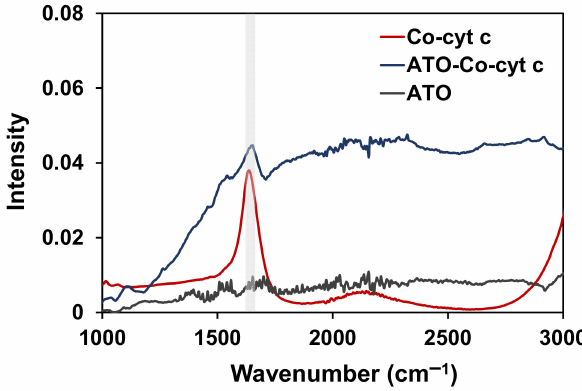
Figure 3. FT-IR spectra of blank ATO (gray), ATO with incorporated Co-cyt c (black), and Co-cyt c in solution (dotted blue). The spectrum of Co-cyt c in solution was taken in 100 mM tris pH 7.5 in liquid IR cell. The spectra for solid samples were obtained directly on the diamond ATR. The IR spectra of ATO-Co-cyt c and Co-cyt c show the characteristic band for amide I at 1640 cm − 1